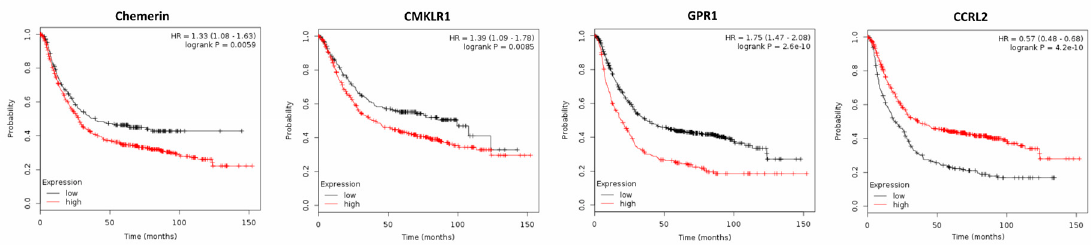
Figure 5. Kaplan–Meier diagrams showing the overall survival (OS) of 876 patients with gastric cancer depending on expression of chemerin and its receptors CMKLR1, GPR1 and CCRL2 in gastric cancer tissue, based on a metaanalysis of DNA microarray data (http://kmplot.com/analysis/) [80] .